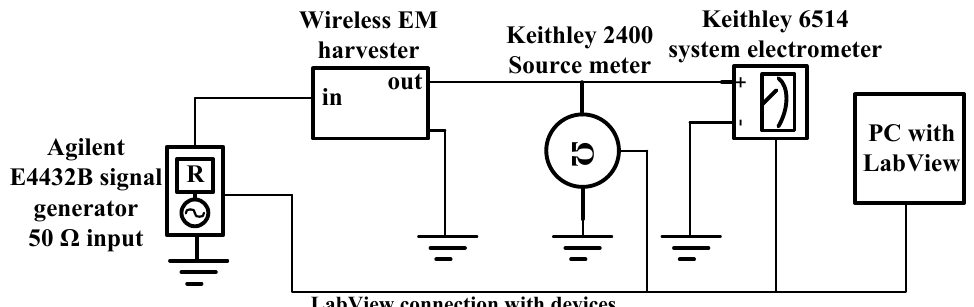
Figure A2. RF to DC power converter characterization